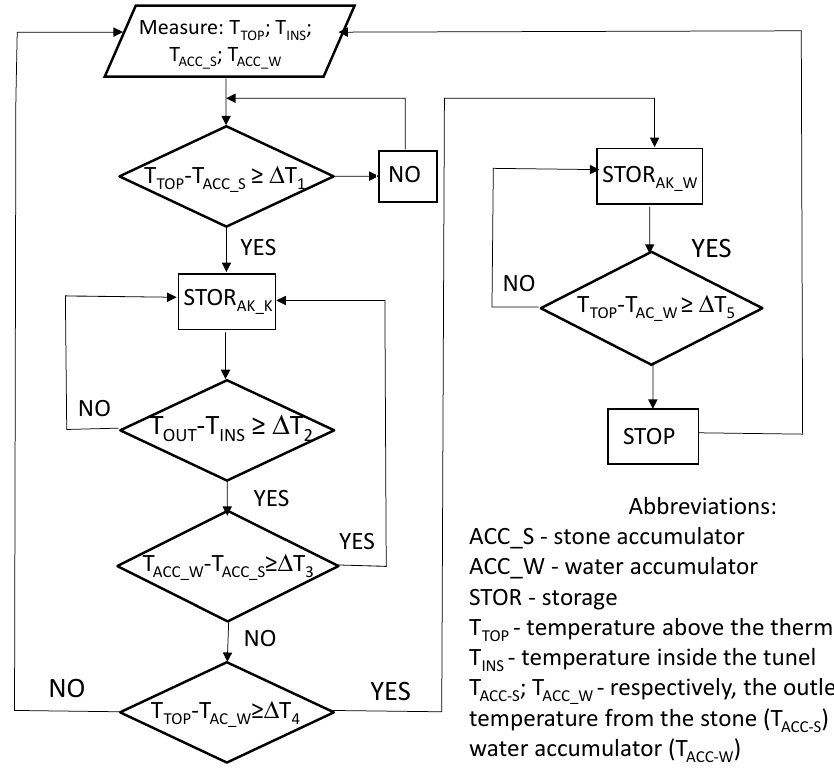
Figure 2. The algorithm diagram for the charging process of the stone-bed and water accumulators.